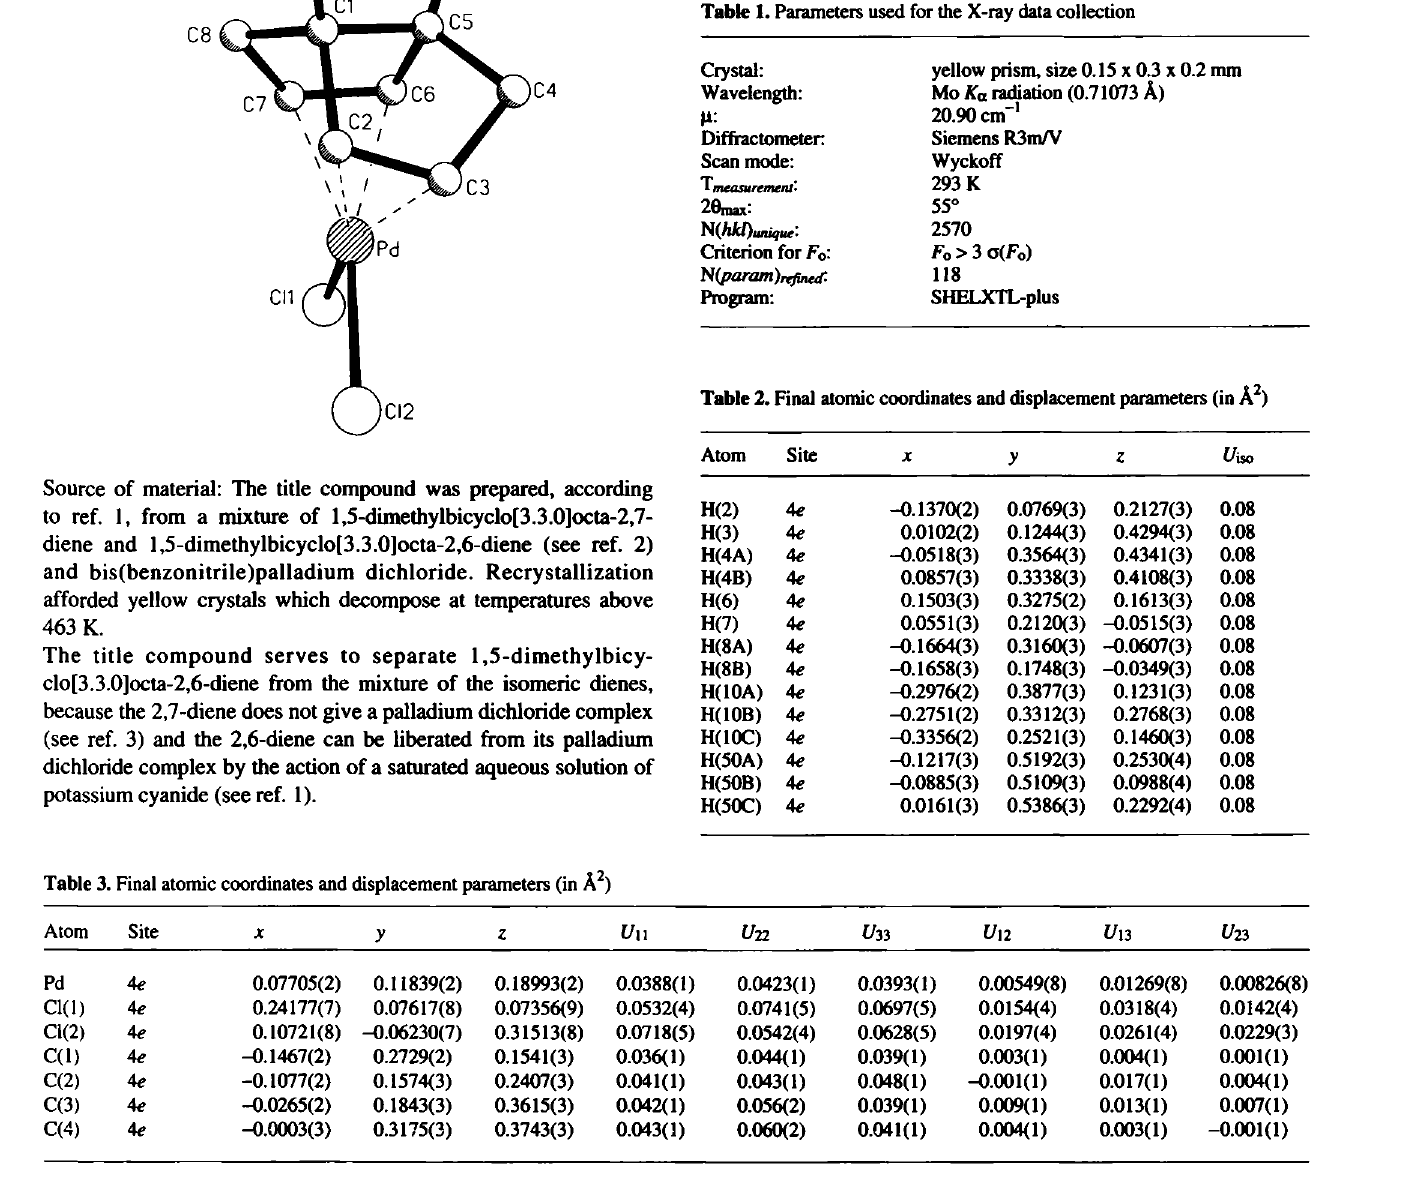
Tabk I. Parameters used for the X-ray data collection Crystal;